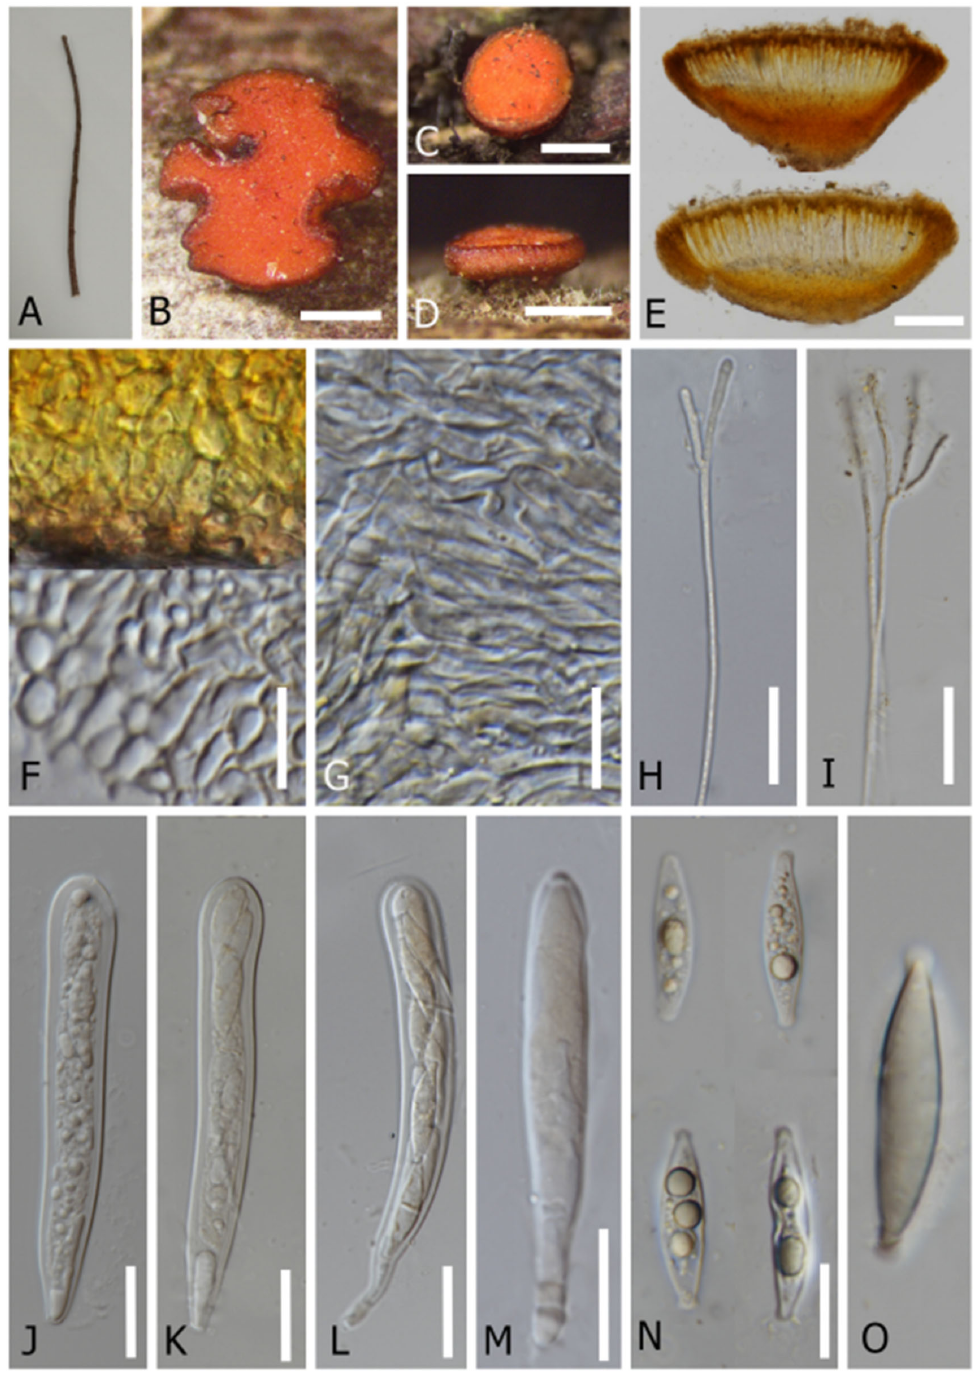
Figure 7. Dicephalospora irregularis (MFLU 22-0054, holotype ). ( A ) Dead twig substrate; ( B – D ) top and side view of apothecia; ( E ) a cross section of an apothecium; ( F ) cells of ectal excipulum; ( G ) cells of medullary excipulum; ( H , I ) a branched paraphyses; ( J – M ) asci (mounted in Melzer’s reagent; ( N , O ) ascospores (mounted in KOH 5%). Scale bars: ( B – D ) = 500 μ m; ( E ) = 200 μ m ; ( F , G ) = 13 μ m; ( H – L ) = 25 μ m; (M) = 30 μ m; ( N ) = 20 μ m;. Dicephalospora rufocornea ( Berk. and Broome) Spooner (Figures 8–10). Index Fungorum number: IF130937; Facesoffungi number:—FOF05900.